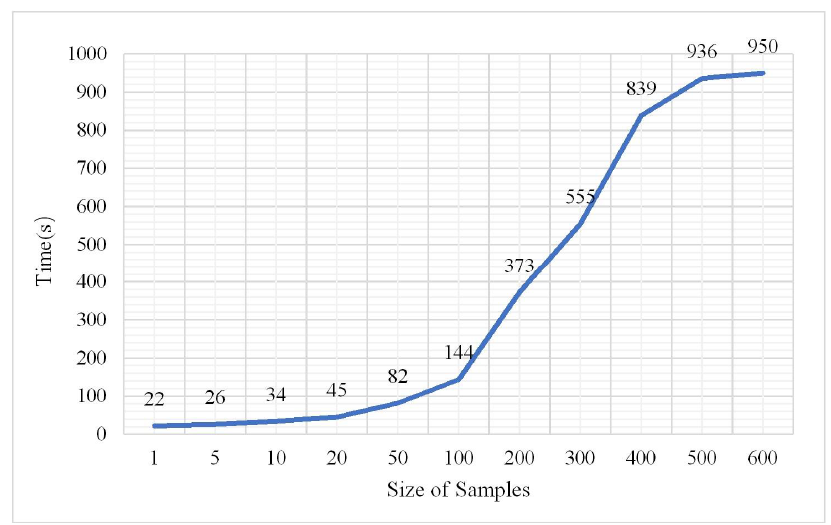
Figure 21. Change in kappa coefficient.